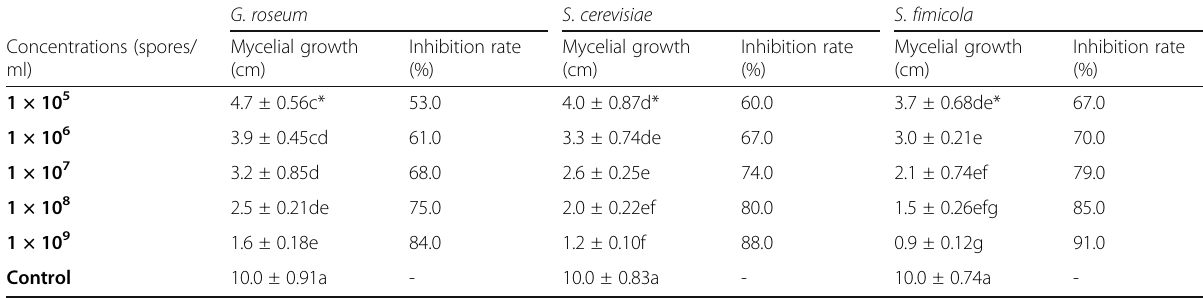
Table 1 Effect of the bio-agents on in vitro mycelial growth of F . graminearum G .